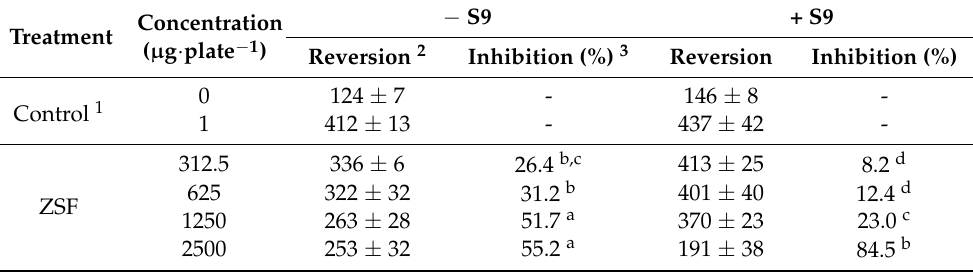
Table 3. Antimutagenic effects of Zanthoxylum schinifolium extracts against mutagens in Salmonella typhimurium TA 100, with or without the S9